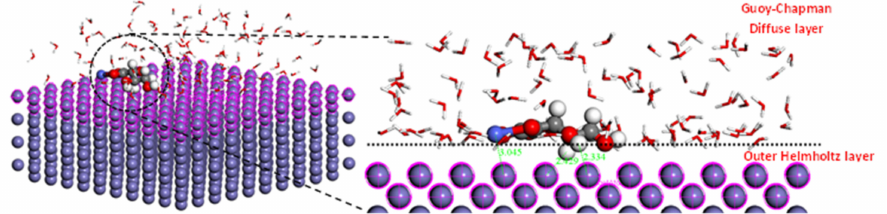
Figure 6. Top and slide views of cobalt-ascorbate molecule adsorption configuration in the presence of 100 water molecule before the onset of the electrocrystallization